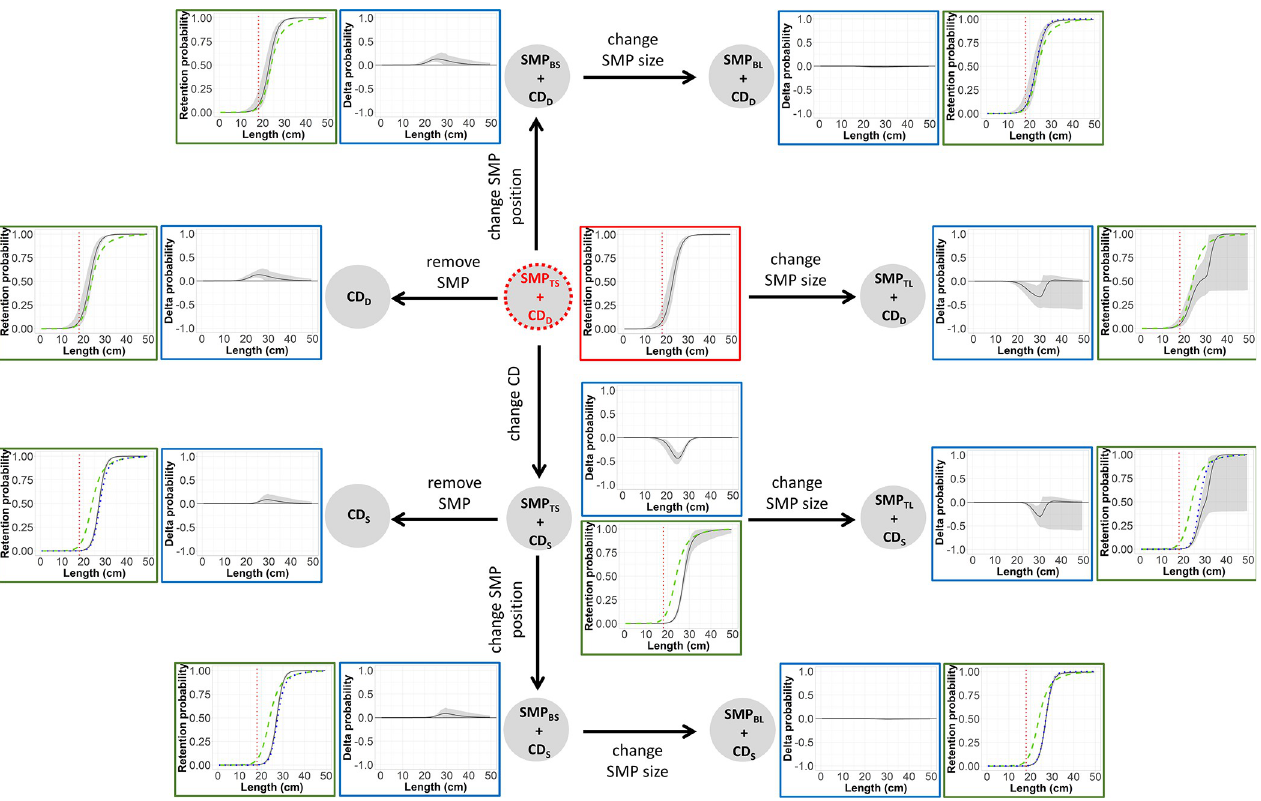
Fig 8. Size selection treatment tree for blue whiting. Delta comparisons (blue boxes) carried out (represented by arrows), which include delta curves for each modification applied in the gear (black line) with corresponding CIs (grey bands), are shown. Each step also includes selectivity plots (green boxes) showing: size selection curves for the treatment gear design (black line) with CIs, baseline gear design (blue dots) and reference gear design (green dashed lines). Vertical red dotted lines correspond to the minimum marketable size: 18 cm.